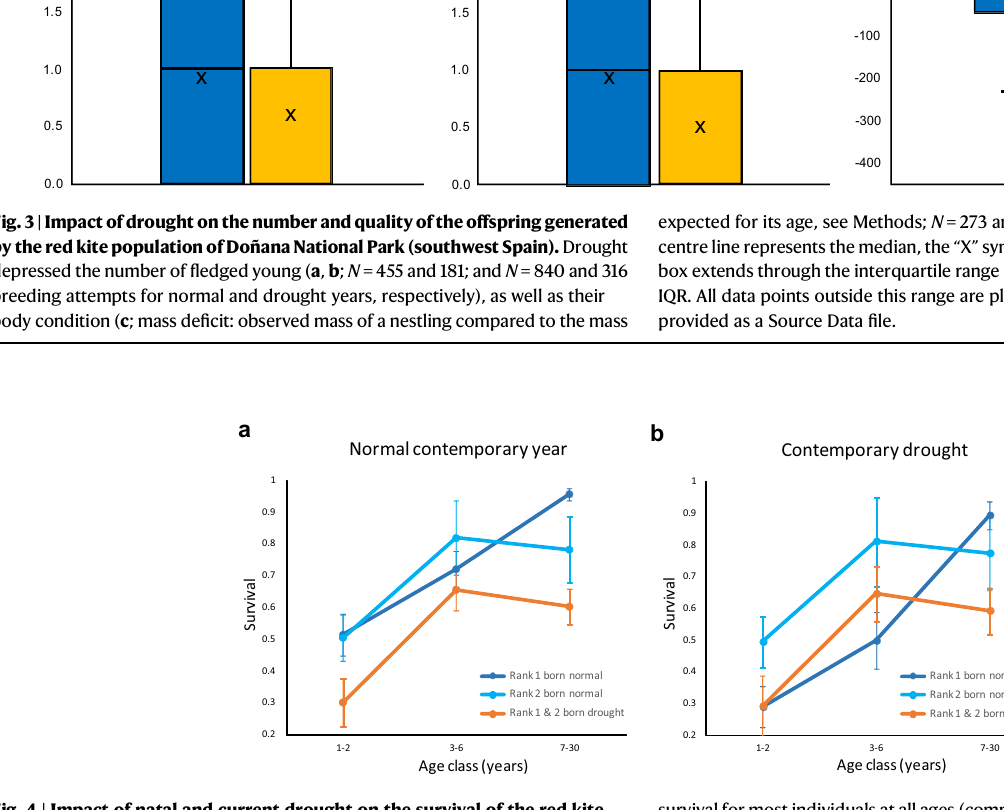
survivalformostindividualsatallages(comparelightbluevsorangelines),except for Rank 1 individuals born in normal years (dark blue line). (3) The latter suffered increased mortality when they encountered drought during their early life (com- paredarkbluelinesbetween a , b overages1 – 2and3 – 6).Thegrapheddatareferto thebestsupportedmodel22ofSupplementaryTable3.Rank1andRank2nestlings had virtually identical survival estimates (differing from the third decimal fi gure); for clarity, they were thus pooled into a single category to avoid two fully over- lapping lines. Based on recapture data from 688 individuals ringed as nestlings. Error bars represent 1 SE. Source data are provided as a Source Data fi